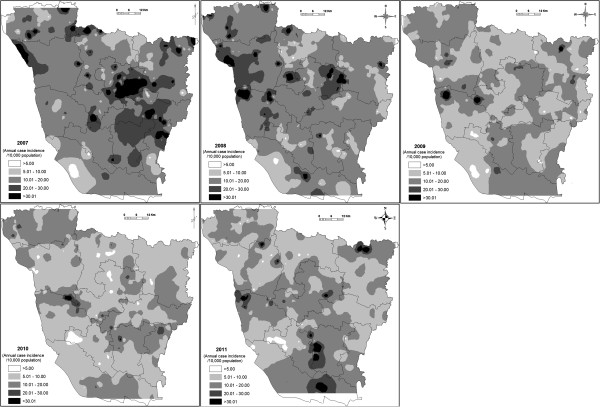
Maps showing the inverse distance weighting interpolation incidence rates of kala-azar disease over different years.